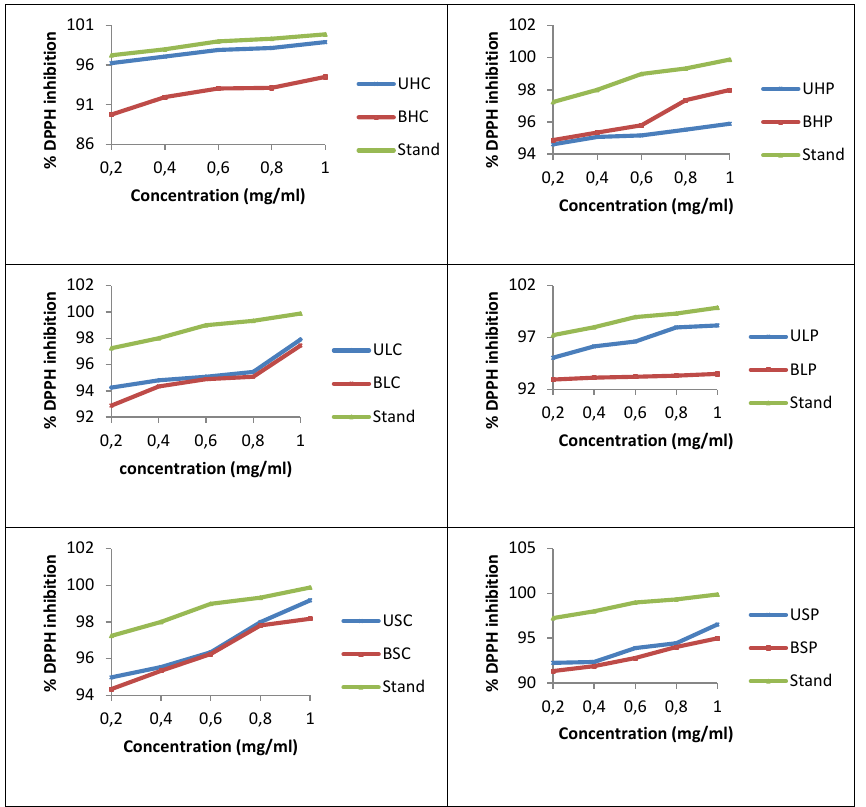
Figure 3: Percentage DPPH inhibition of cardaba banana and plantain flour